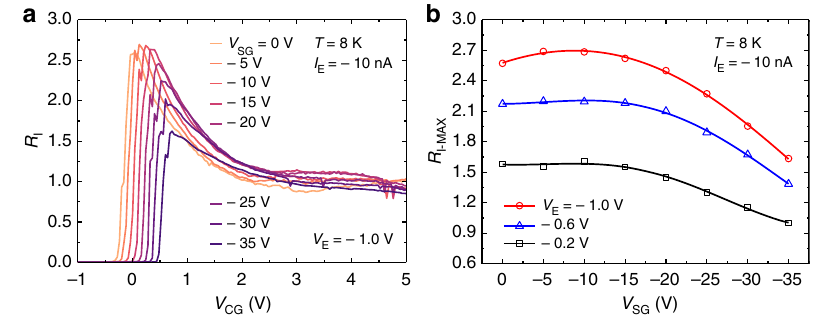
Fig. 4 Substrate (back-gate) voltage V SG dependence of the device characteristics. a R I as a function of V CG using V SG as a parameter. b Maximum value R I- R V V I as a function of SG using E as MAX of